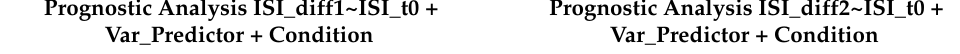
Table 2. Prognostic regression analysis coefficients. A p -value indicates a significance of relationship between the baseline variable and ISI improvement post-treatment. The greater ISI improvement reflecting improvement after treatment is characterized by the higher estimate. In the prognostic analysis columns estimates, standard errors, and p -values are presented for the main effect of the analyzed